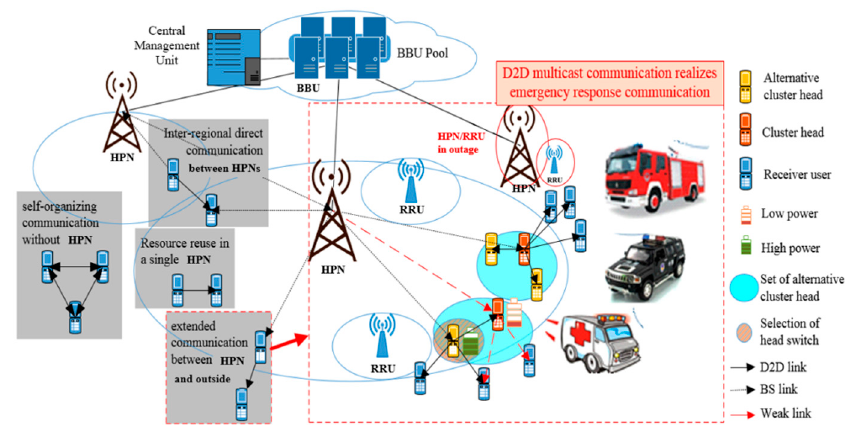
Figure 1. Device-to-device (D2D) technology and the application in PSN.